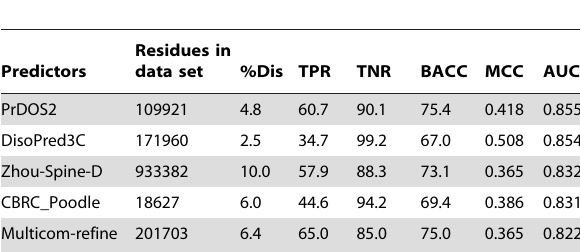
Table 5. Top five predictors tested by CASP9 targets (117